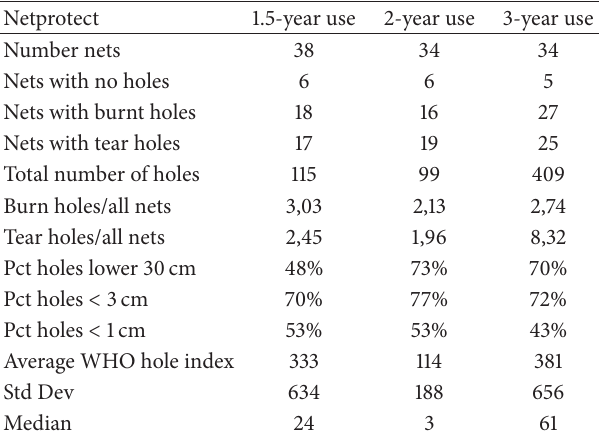
Table 5: Net damages and WHO hole index after 3 years of